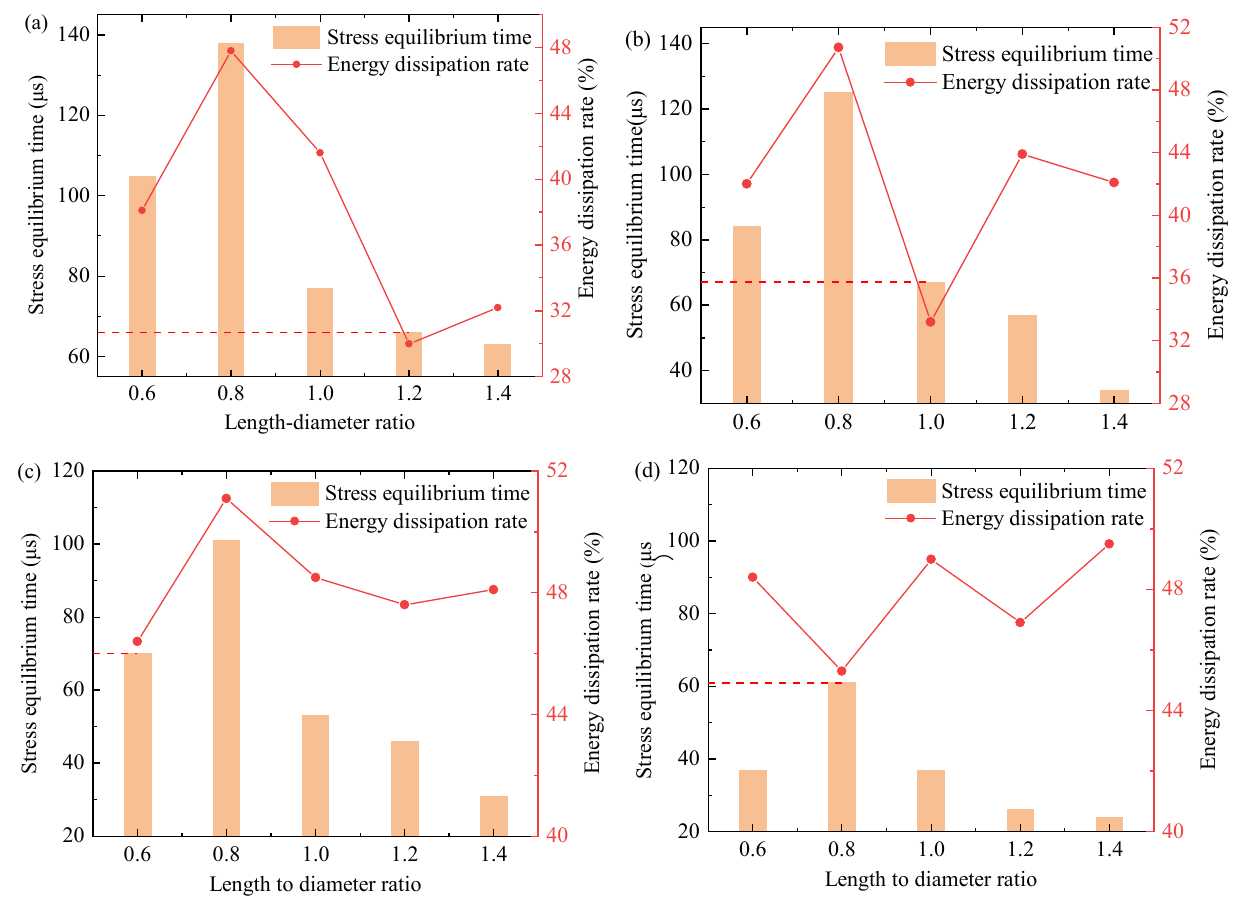
Figure 9. Energy dissipation rate–stress equilibrium time curve ( a ) v = 8 m/s ( b ) v = 10 m/s ( c ) v = 12 m/s ( d ) v = 14 m/s.